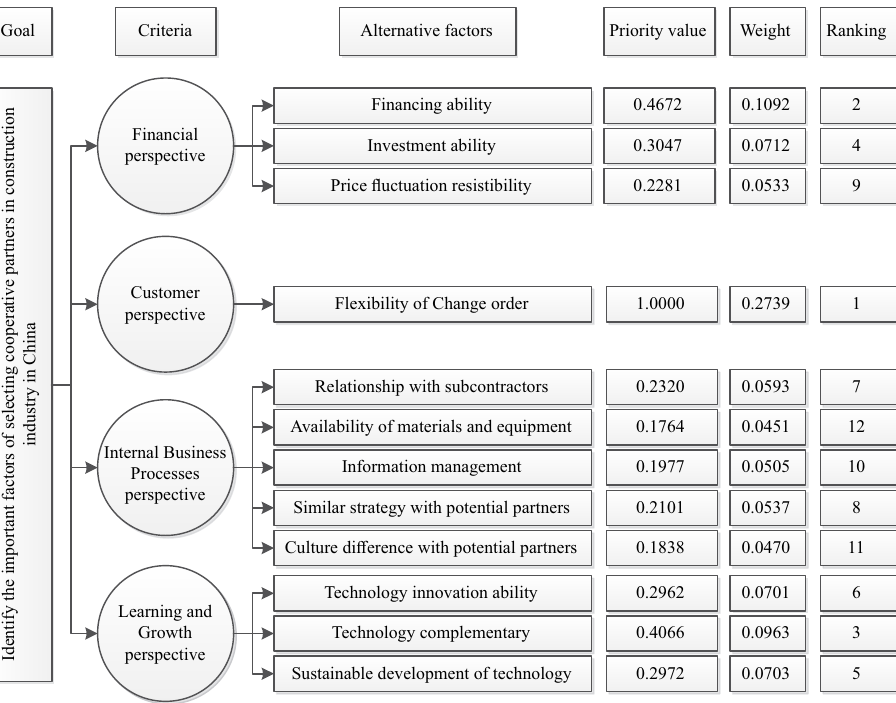
Fig. 1. FAHP analysed